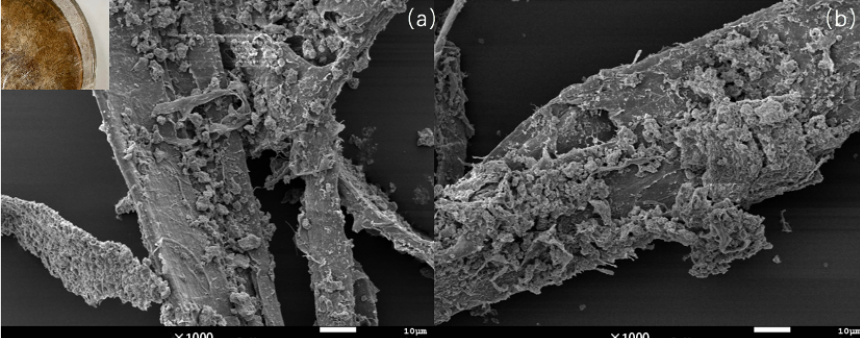
Figure 4. SEM images of PNMBC before ( a ) and after ( b ) adsorption of Cu ( Ⅱ ).